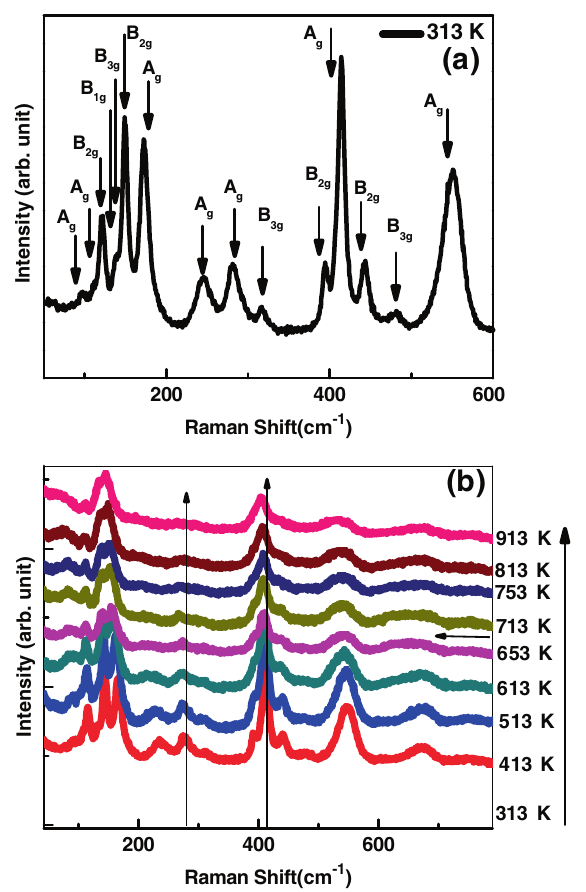
Fig. 1 a Room temperature Raman modes and the modes assign- ment are illustrated. b A close view of change in low-frequency Raman spectra as function of temperature from 300 to 913 K. Merger of A 1g and B 1g (B 3g ) modes to a single A 1g mode above 650